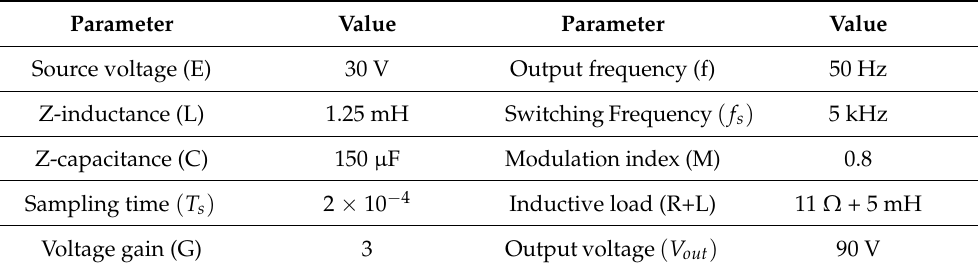
The 1 ф /SB/MSVM has been chosen as a sample of the studied modulation schemes.